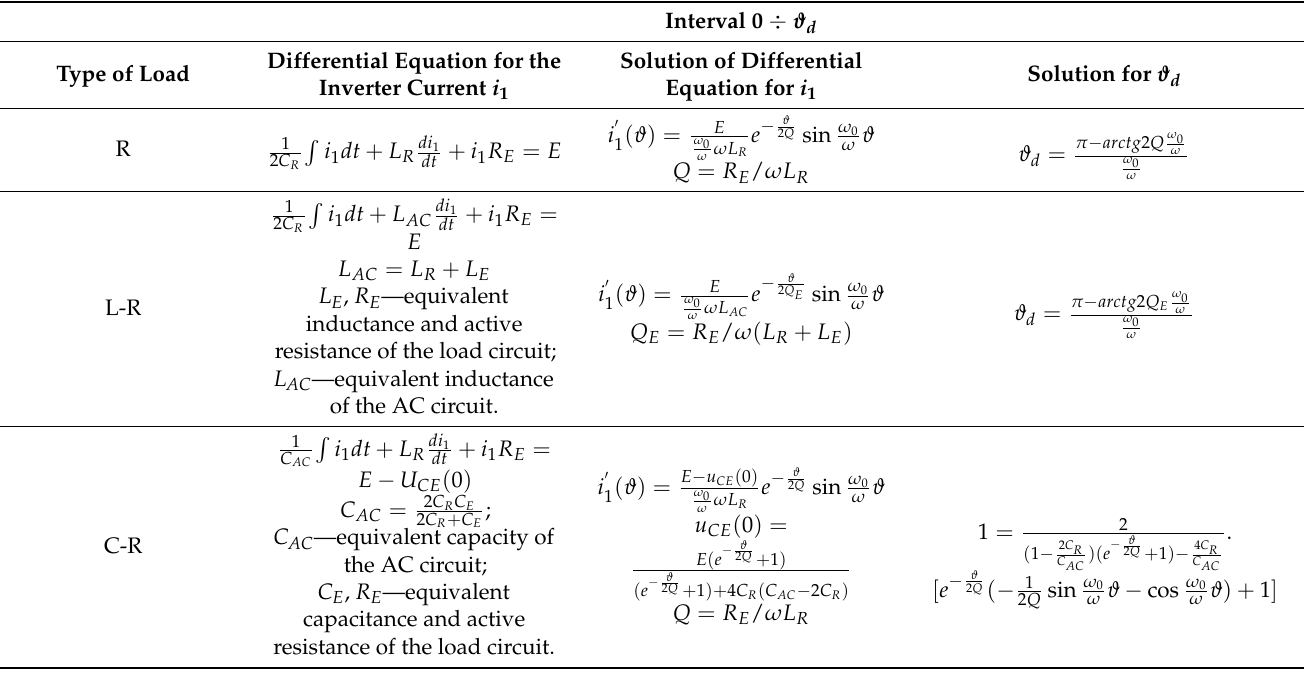
Table 1. Mathematical expressions describing the first interval of the scheme’s